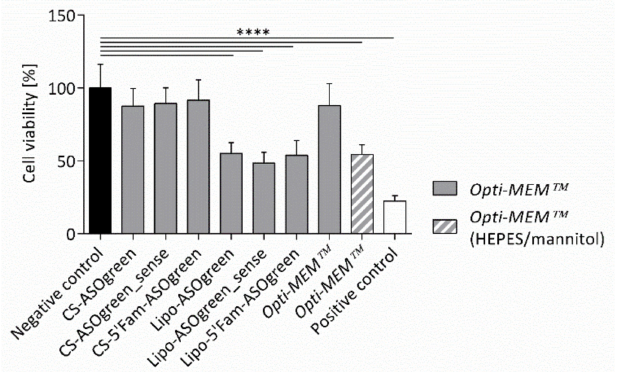
Figure 6. E ff ect of di ff erent ASOs in combination with Lipofectamine (Lipo) and CS on the viability of NCI-H441 cells. NCI-H441 cells were incubated with the samples for 24 h before a 3-(4,5-dimethylthiazol-2-yl)-2,5-diphenyltetrazolium bromide (MTT) assay was conducted. Cell culture medium was used as a negative control; Triton ® X-100 was used as a positive control. While CS in combination with ASOs only had a slight e ff ect on the cell viability (~80–90%), the decrease in cell viability caused by Lipofectamine in combination with ASOs was highly significant (~50%; p ≤ 0.0001 (****); n =